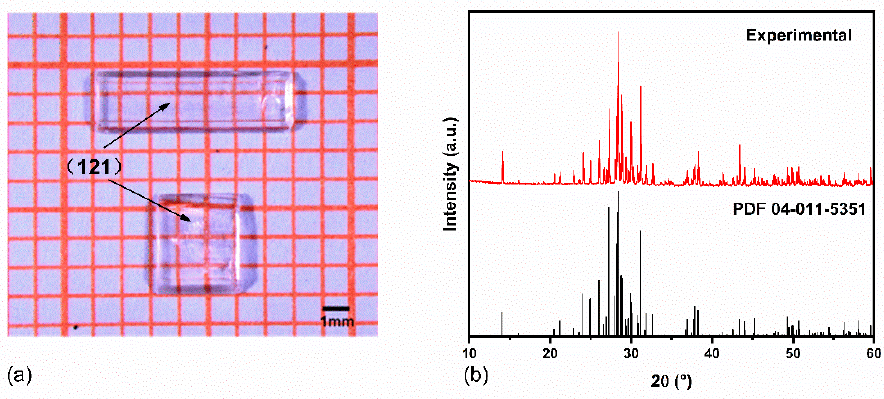
Figure 1. ( a ) The photograph of the Rb 3 Ti 3 P 5 O 20 single crystals. The crystal faces are all perpendicular to the page (121); ( b ) X-ray powder diffraction pattern of the as-grown Rb 3 Ti 3 P 5 O 20 single crystal.